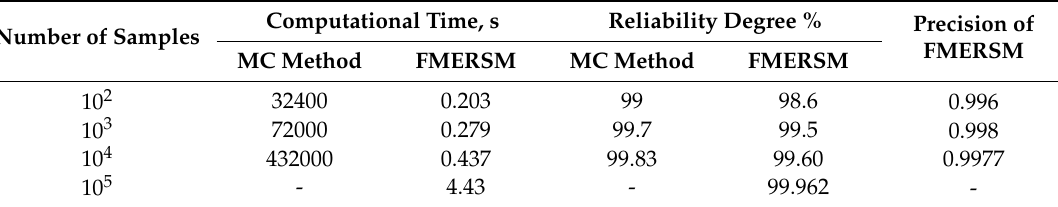
Table 6. Dynamic probabilistic computational results with di ff erent methods. FMERSM: fuzzy multi-extremum response surface method, MC: Monte Carlo.